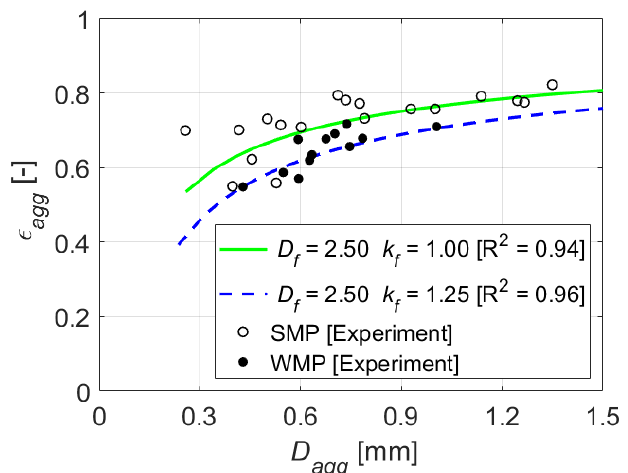
Figure 4. The porosity of the experimentally formed milk powder agglomerates (dots) [30] and the theoretically calculated porosity for monodispersed agglomerates at different pairs of fractal properties (lines) over their diameter.